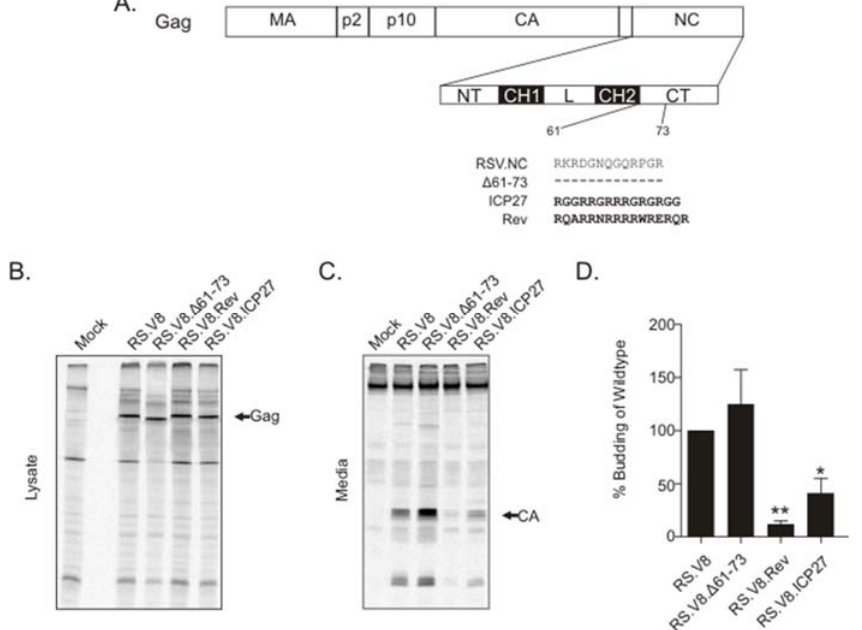
Figure 1. Budding analysis of proviral basic residue motif (BR) restoration mutants. ( A ) Schematic diagram of Rous sarcoma virus (RSV) NC and nucleolar restoration mutants. MA, matrix; CA, capsid; NC, nucleocapsid; NT, N-terminal region; CH1, Cys-His box 1; L, linker region; CH2, Cys-His box 2; CT, C-terminal region. Wild-type residues are shown for the C-terminal basic region. Dashed lines represent deleted residues ( ∆ 61-73). Bold residues depict sequences used to replace the deleted amino acids (ICP27 BR and Rev BR). ( B ) Gag expression within the cell lysates after a 5-min labeling period with 35 S-Met / Cys. After collection of cell lysates and immunoprecipitation using an α -RSV antibody, the proteins were separated by sodium dodecyl sulfate-polyacrylamide gel electrophoresis (SDS-PAGE) and visualized by phosphorimaging. Di ff erences in molecular weights (predicted masses listed in parentheses) were noticeable, with ∆ 61-73 mutant Gag (73 kD) running faster than wild-type (74.5 kD), and both Rev (75.3 kD) and ICP27 (74.7 kD) running slightly slower in the gel. The arrow indicates the position of the Gag band. ( C ) After radioactive labeling for 2.5 h, supernatants were clarified, and virus particles were pelleted and immunoprecipitated using an α -RSV antibody (media samples). Proteins were separated by SDS-PAGE and visualized by phosphorimaging. The arrow indicates CA (25.8 kD). ( D ) The average of four independent budding assays is presented within the bar graph, with the bars representing the standard error. * p -value = 0.0253, ** p -value = 0.0013 calculated by Student’s t